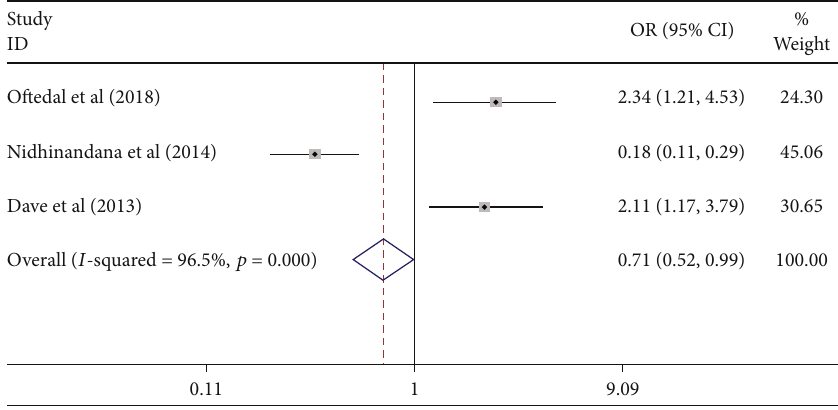
Figure 8: E ff ect size of diabetes on the uncontrolled